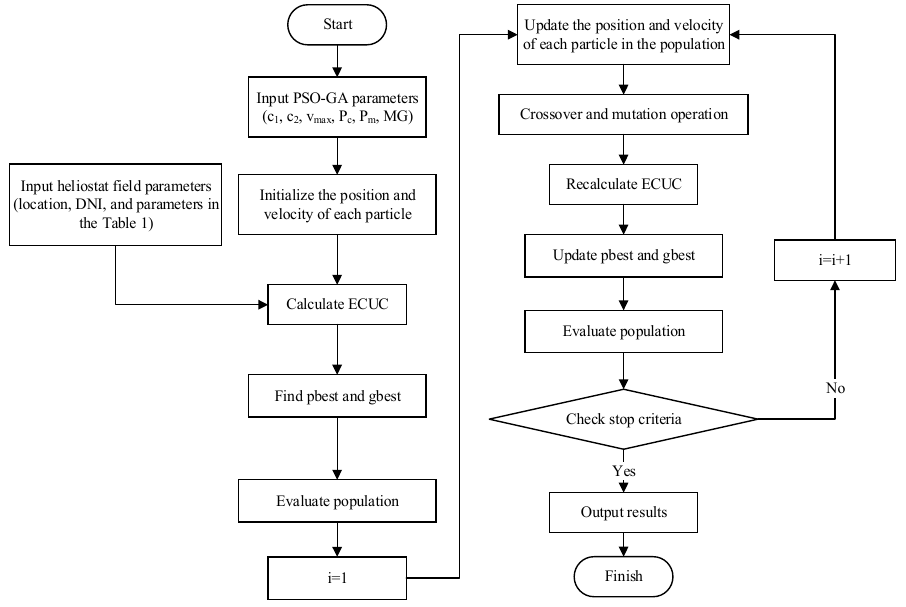
Figure 2. Flow chart of the hybrid particle swarm optimization (PSO)-genetic algorithm (GA).